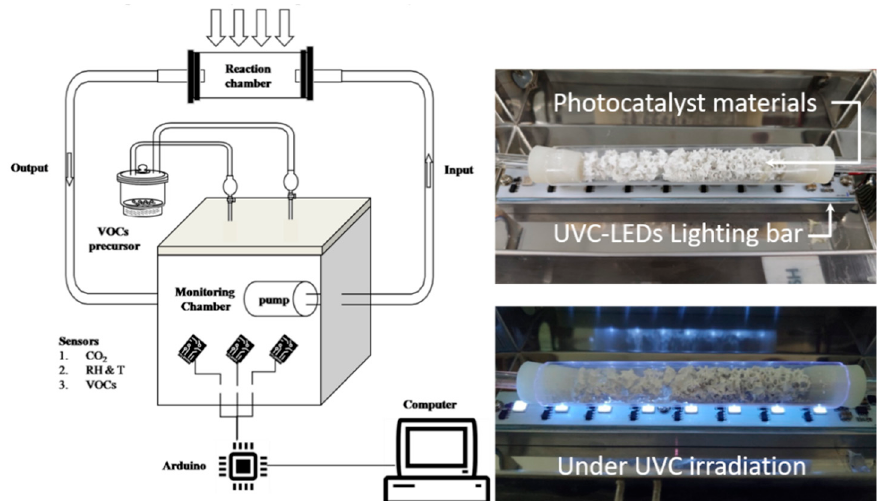
Figure 6. Schematic design of the experimental setup used for the study of photocatalytic activity of β -Ga 2 O 3 related to degrade volatile organic compound (VOC) gas. Photographs of a reaction chamber consisting of a UVC lighting bar and β -Ga 2 O 3 photocatalyst coated porous ceramic platform inside a quartz reactor.